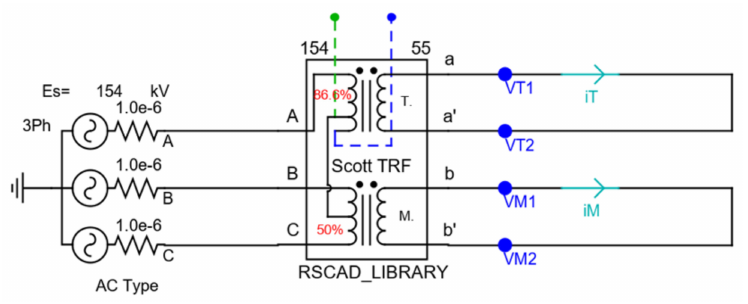
Figure 4. Circuit configuration for impedance voltage test of the Library Scott transformer